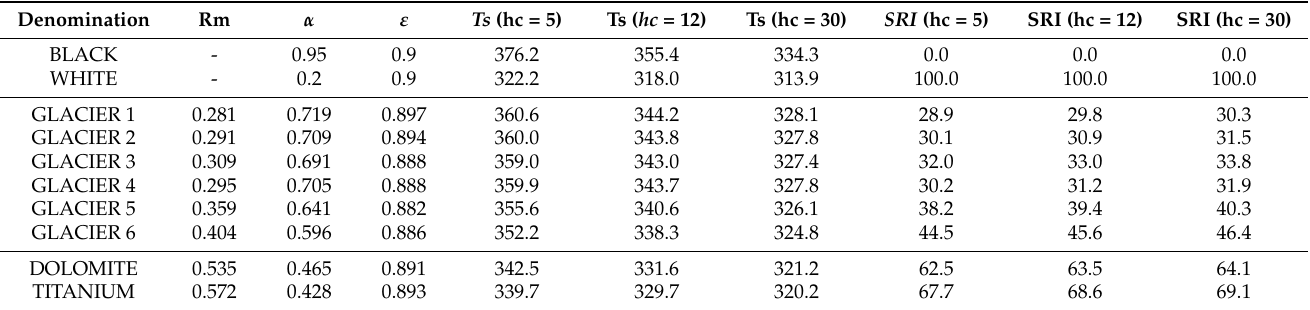
Table 3. Albedo average results (R m ), solar absorptance ( α ), thermal emittance ( ε ), the temperature that each sample would reach ( T s ) and its solar reflectance index ( SRI ) for three convection coefficients ( h c ), corresponding to three wind